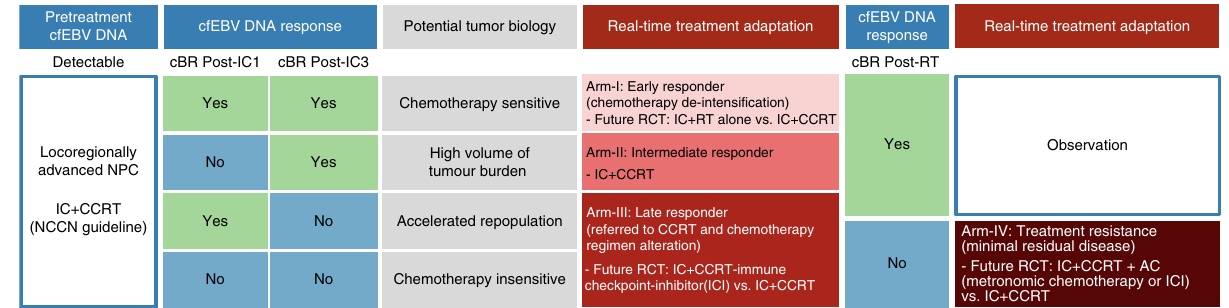
Fig. 5 Clinical trial utilising longitudinal cell-free Epstein – Barr virus (cfEBV) DNA response to individualise combination systemic treatment with radiotherapy. For early responders (Arm I), we proposed testing the omission of concurrent chemotherapy with radiotherapy. For intermediate responders (Arm II), we proposed maintaining chemotherapy intensity with concurrent radio-chemotherapy. For late responders (Arm III), alternative systemic combinations (e.g. immunotherapy) with radiotherapy rather than additional induction chemotherapy cycles ought to be considered. Lastly, for treatment- resistant subgroup (Arm IV), there may be a role for further adjuvant chemotherapy intensi fi cation with metronomic chemotherapy or concurrent chemotherapy regimens to cisplatin and nedaplatin, which is consistent who were treated with IC plus CCRT±AC; (3) pretreatment EBV DNA >0 copies/ with the published literature 12,13,15 . The stepwise selection process and corre- ml; and (4) biomarker surveillance that involves cfEBV DNA quanti fi cation after every IC cycle, pre-CCRT and within 1 week at the end of CCRT (the collection sponding sample sizes are presented in Supplementary Fig. 1. All patients under- schema is presented in Supplementary Fig. 2). To further account for treatment went required pretreatment evaluations and were restaged according to the Union heterogeneity, we restricted the IC regimens to TPF, TP, PF and GP and for International Cancer Control/American Joint Committee on Cancer Eighth